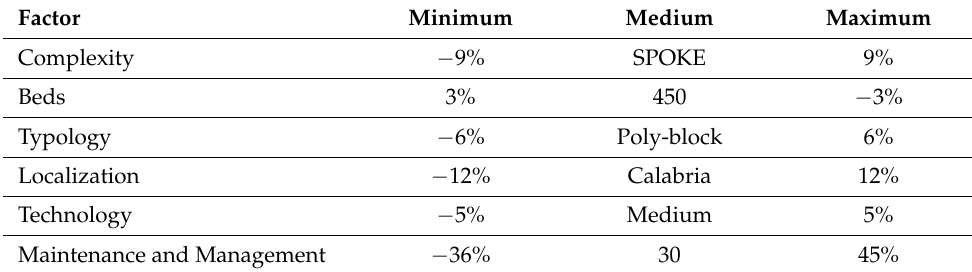
Table 6. Construction cost variation preliminary estimation